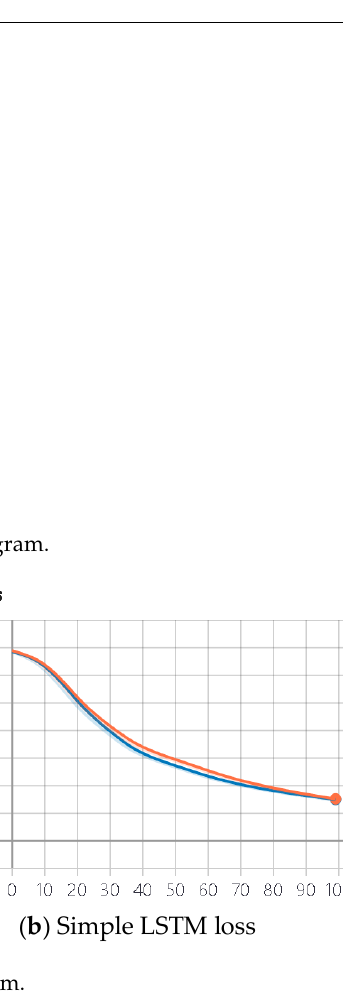
Figure 13. Simple LSTM training parameters diagram.